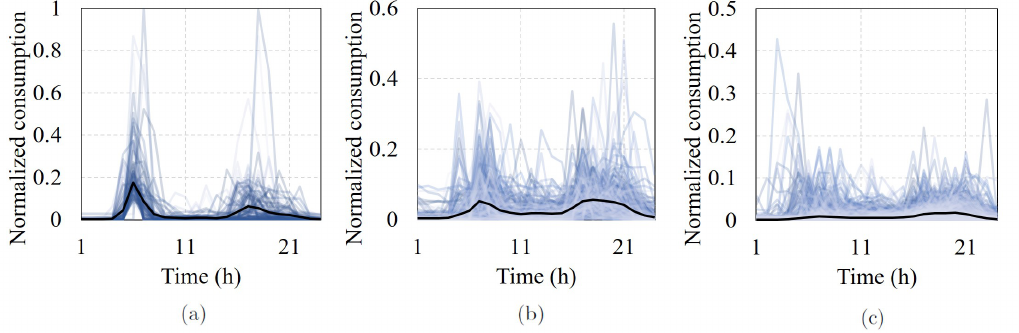
Figure 9. Summer profiles for three clusters using the FCM algorithm: ( a ) Cluster 1; ( b ) Cluster 2; ( c ) Cluster 3.